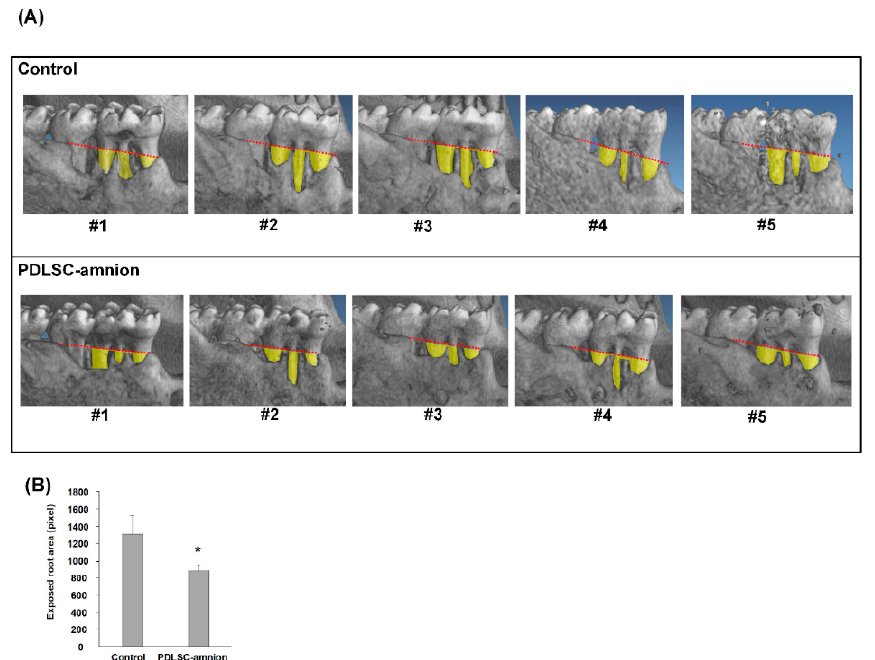
Figure 2. Periodontal regeneration in rat periodontal defects. ( A ) Micro-CT images of periodontal defects four weeks post-transplantation. The buccal area of the rat first mandibular molar was demonstrated from five rats in each test group. The yellow area shows the denuded root surface area below the red line, connecting the mesial and distal alveolar bone crests. ( B ) Quantification of the yellow area in micro-CT images taken at four weeks after transplantation. The yellow area is smaller in the PDLSC-amnion group than in the control, suggesting the enhanced new tissue formation. * p < 0.05, Student’s t